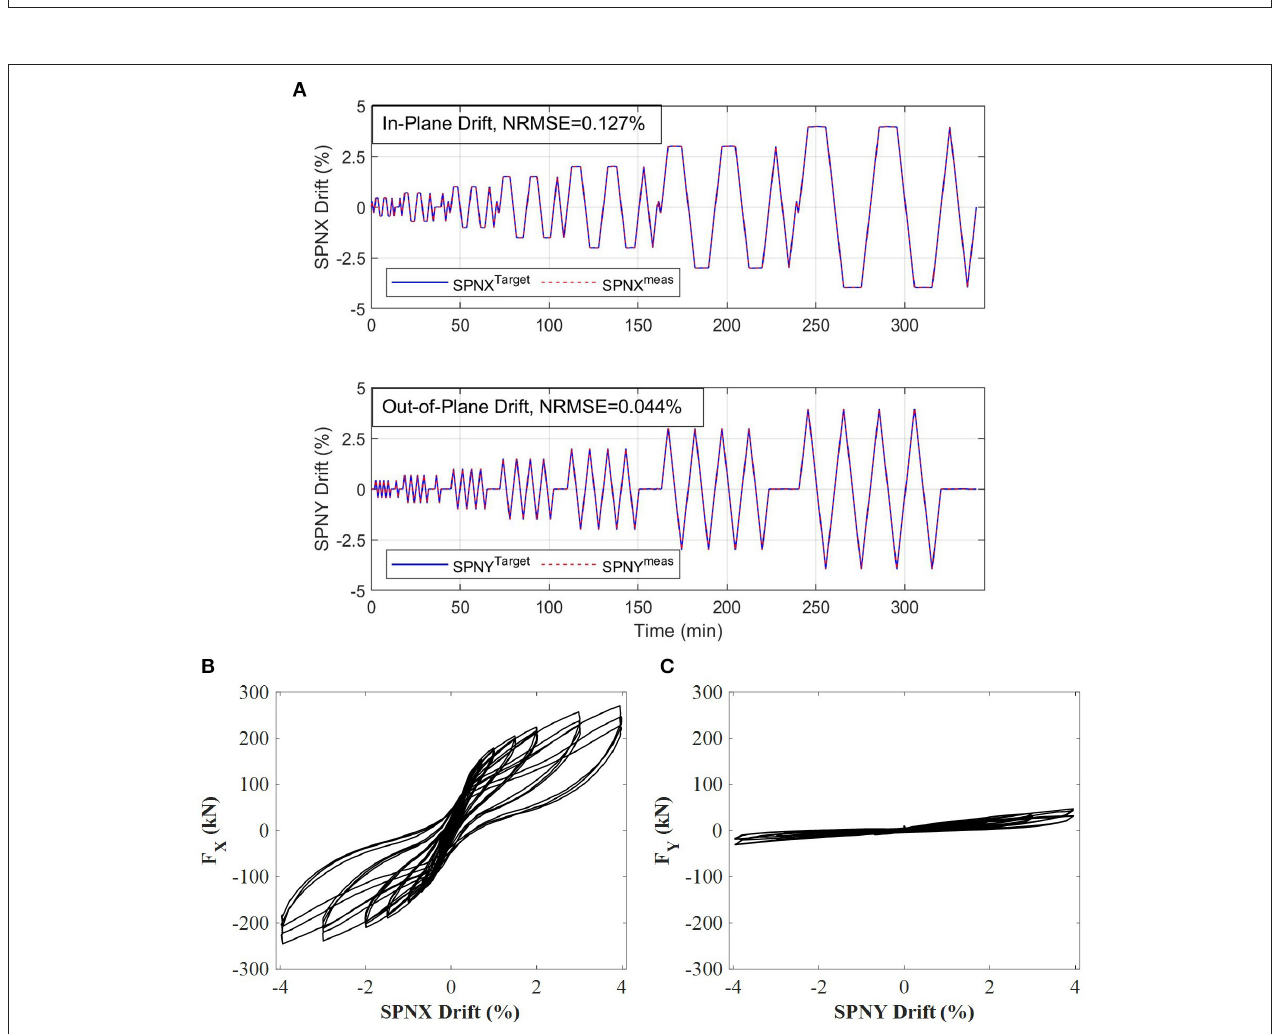
FIGURE 14 | Multi-directional test of cross-laminated timber self-centering coupled walls-floor diaphragm gravity system: (A) comparison of target drift and measured subassembly drift, (B) in-plan lateral load-story drift response, and (C) out-of-plane lateral load-story drift response (courtesy of Amer, 2021).